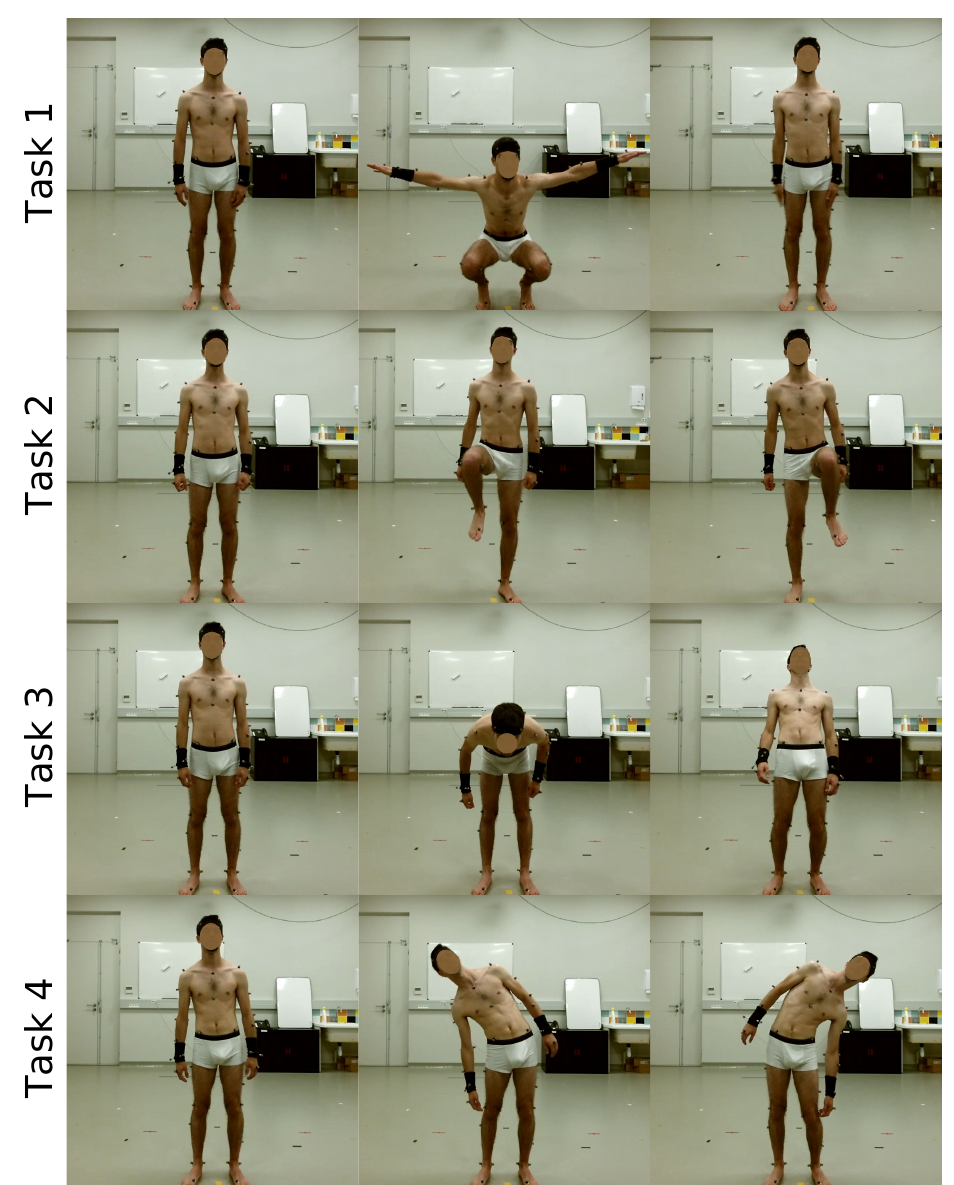
Figure 2. Tasks for measurement: ( 1 ) squat with lateral arm extensions, ( 2 ) stepping (left and right), ( 3 ) body tilt in sagittal plane and ( 4 ) body tilt in frontal